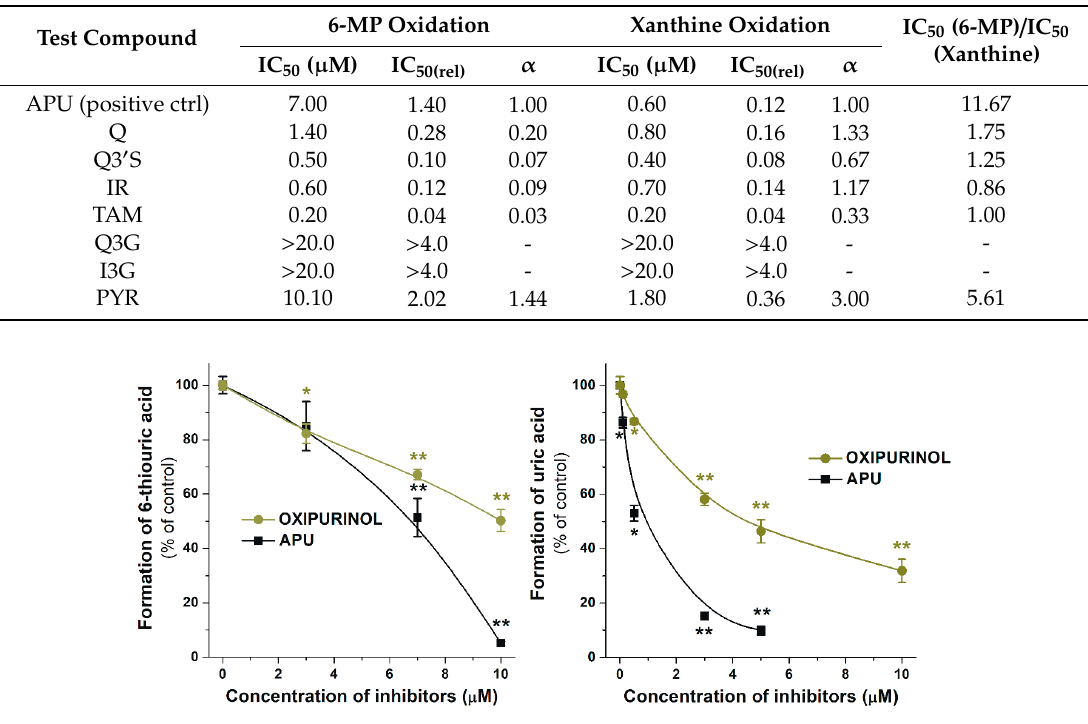
Figure 4. Inhibitory effects of oxipurinol and allopurinol (APU) on XO-catalyzed oxidation of 6-MP and xanthine after 40 and 8 min incubations, respectively. * p < 0.05; ** p < 0.01). Table 1. Inhibition of XO-catalyzed 6-TU formation and uric acid formation by APU, Q, Q3 ′ S, IR, TAM, Q3G, I3G, and PYR. IC 50 : concentration of the compound which induces 50% inhibition of metabolite formation, IC 50(rel) = IC 50 of the inhibitor divided by the substrate concentration (5 μ M 6- MP), α = IC 50 of the inhibitor divided by IC 50 of the positive control.